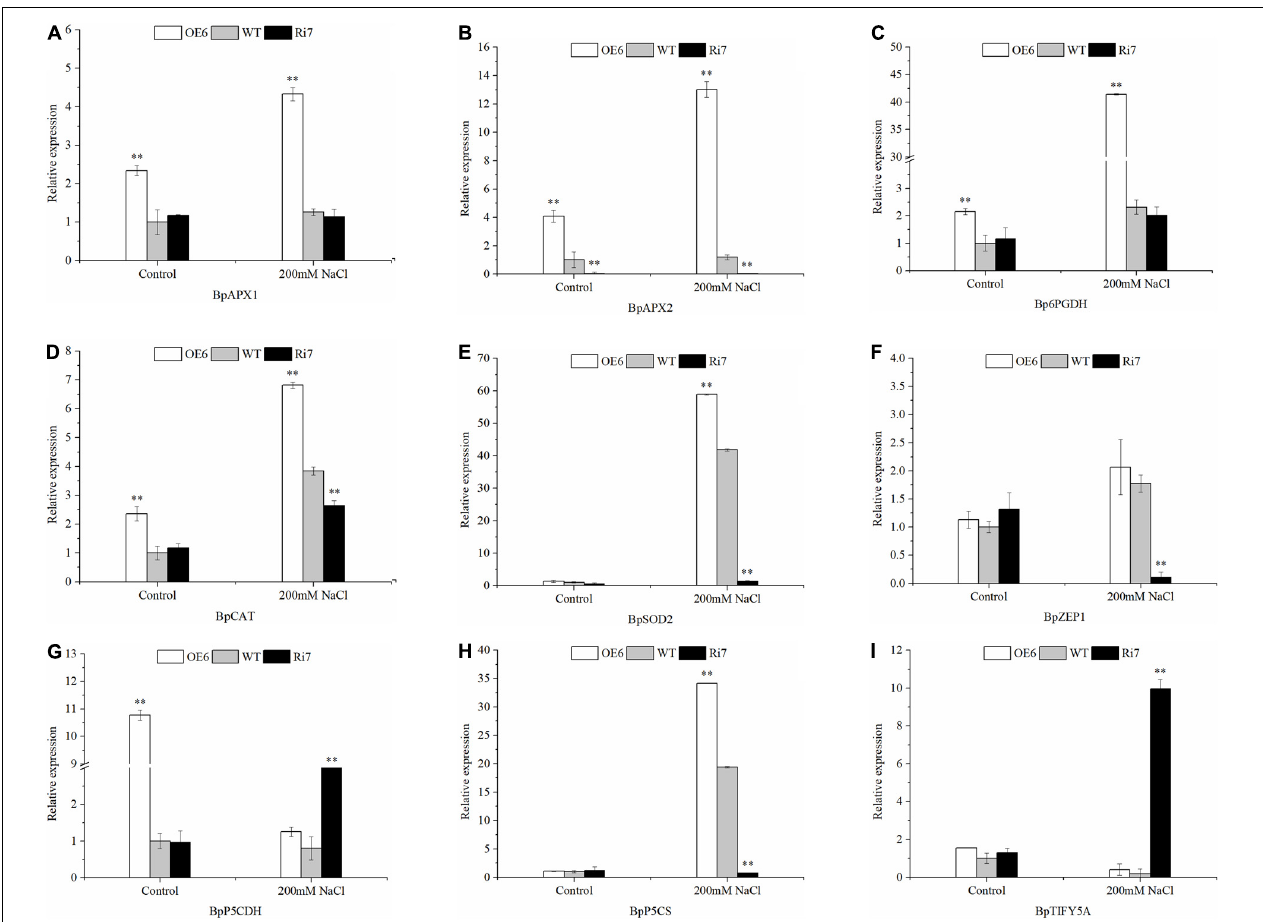
FIGURE 6 | RT-PCR analysis of the expression levels of salt-responsive genes in Ri lines, WT, and OE lines before and after salt stress. (A) BpAPX1 , (B) BpAPX2 , (C) Bp6PGDH , (D) BpCAT , (E) BpSOD2 , (F) BpZEP1 , (G) BpP5CDH , (H) BpP5CS , and (I) BpTIFY5A . Asterisks denote significant differences: ∗∗ P ≤ 0.01. Error bars represent standard error for three